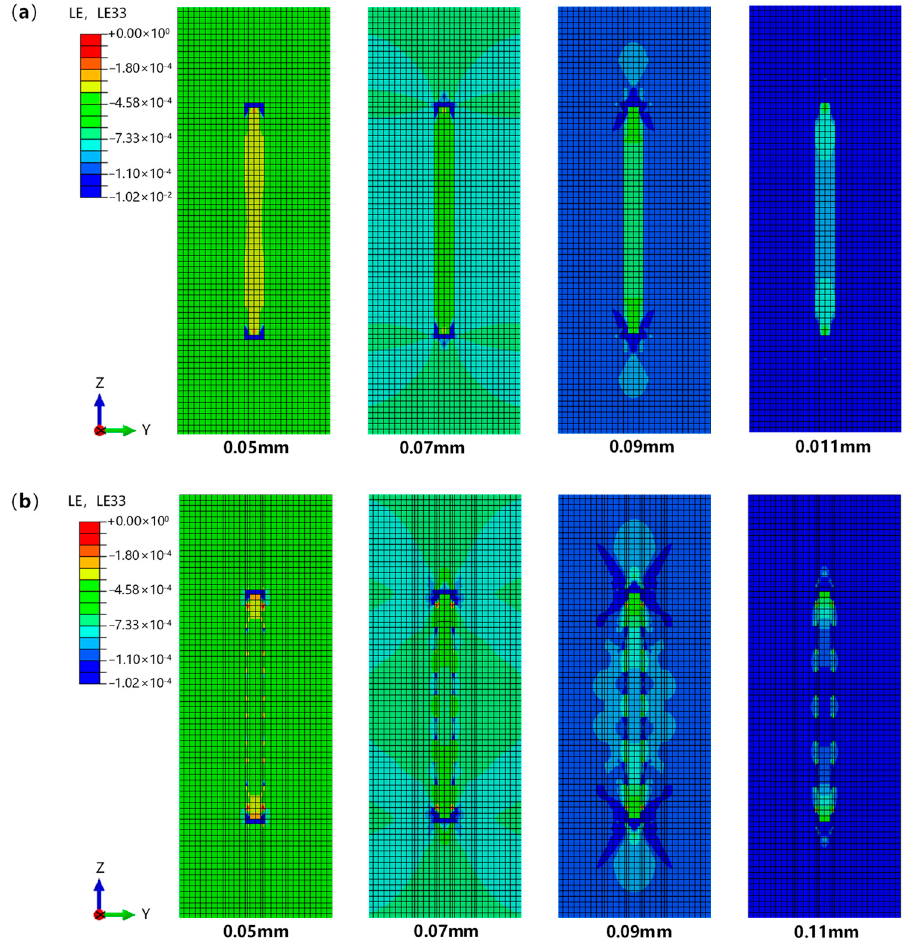
Figure 16. Strain distribution along the z direction in regions surrounding the 90° ( a ) flat and ( b ) rough sensors under progressive compressive displacements.